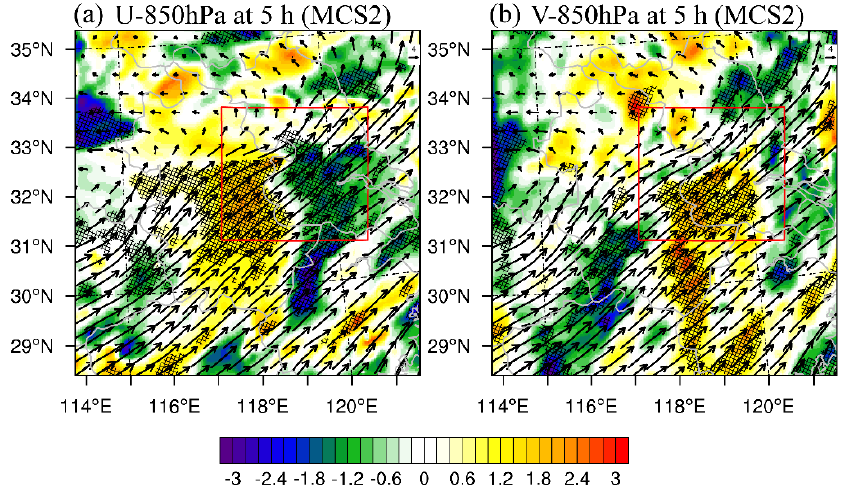
Figure 11. Sensitivity of hourly precipitation in the MCS2 region (red rectangle) at 19:00 UTC 6 July (7 h) to ( a ) 850-hPa zonal wind (shaded, mm (m s −1 ) −1 ) and ( b ) 850-hPa meridional wind (shaded, mm (m s −1 ) −1 ) at 17:00 UTC (5 h). Black shading indicates regions where the sensitivity is statistically significant at the 95% confidence level. The black vectors are 850-hPa ensemble mean wind fields.